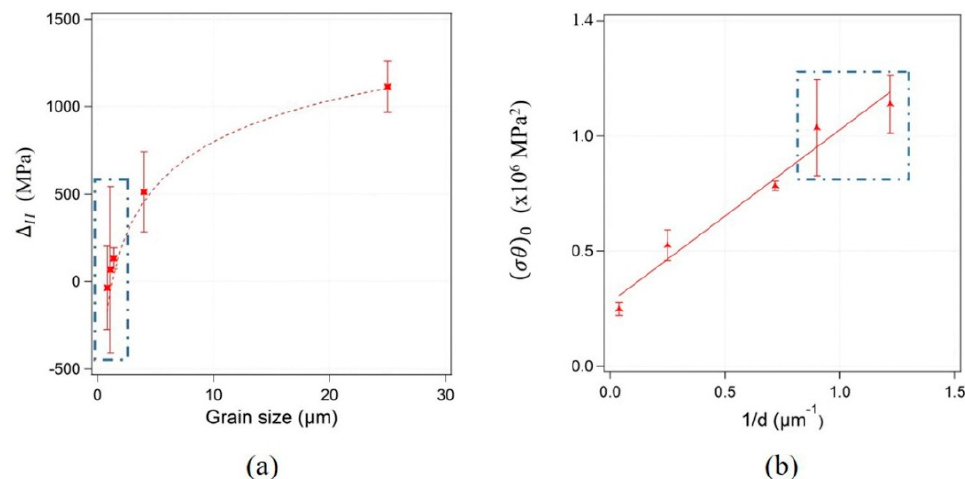
Figure 7. Evolution of the latent hardening rate ( ∆ II ) in stage II of strain hardening as a function of grain size ( a ) for the five sintered samples. Evolution of ( σθ ) 0 as a function of 1/d for the five sintered samples ( b ). The two UFG samples are framed in blue.